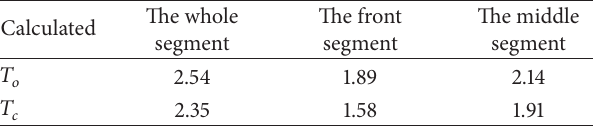
In Figure 10, the parameters of simulated curve 1 are 𝐾 𝑝 = = 10.72 . The parameters of simulated curve 2 are 9.52 , 𝐾 𝑖 = 6.83 , 𝐾 = 7.7 , and the parameters of simulated 𝐾 𝑝 𝑖 curve 3 are 𝐾 𝑝 = 8 , 𝐾 𝑖 = 8.87 . With small